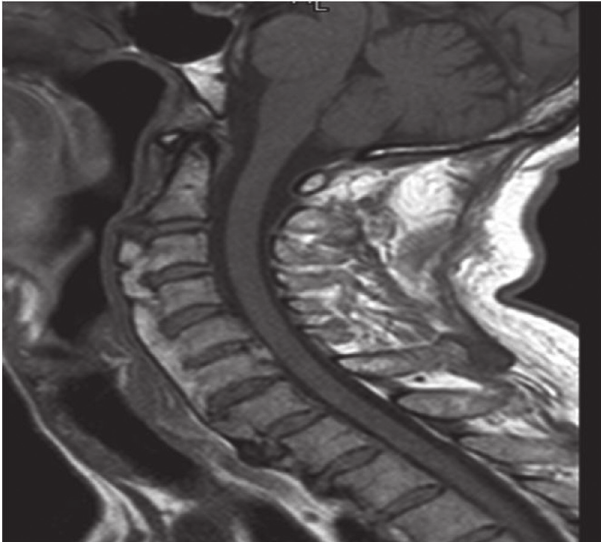
Figure 2 Plain profile X-ray of the cervical spine showing diffuse calcification in the anterior longitudinal ligament and calcification areas in the posterior longitudinal ligament.